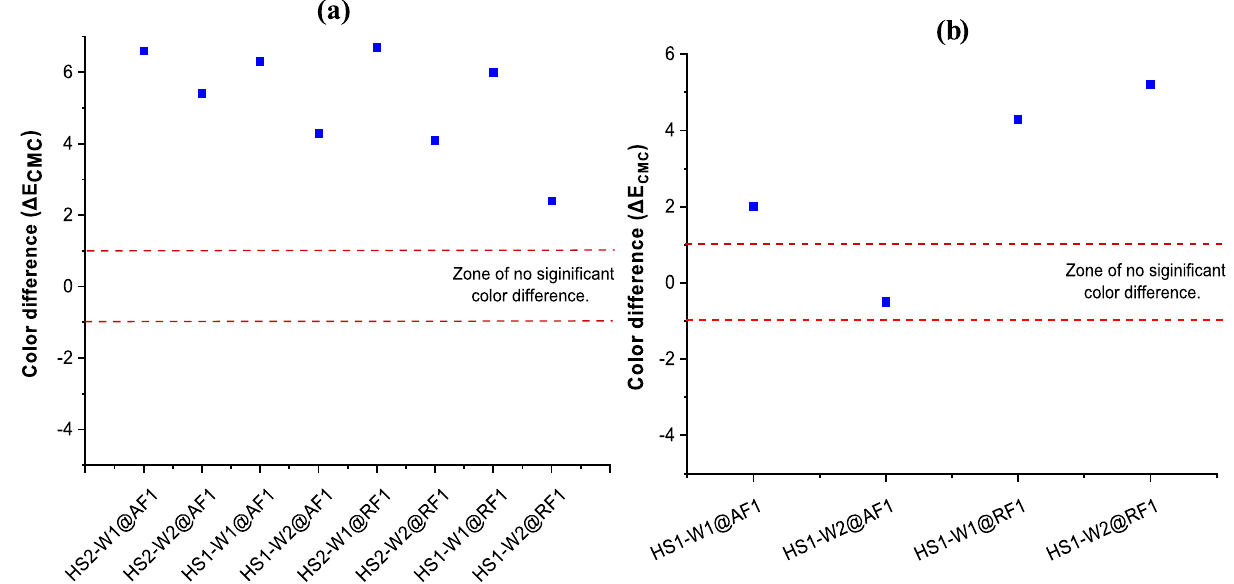
Figure 3. Color difference (ΔE CMC ) between ( a ) HS dyed (two-steps) and conventional exhaust dyed samples; ( b ) One-step and two-steps HS dyed samples (shaded square = color difference